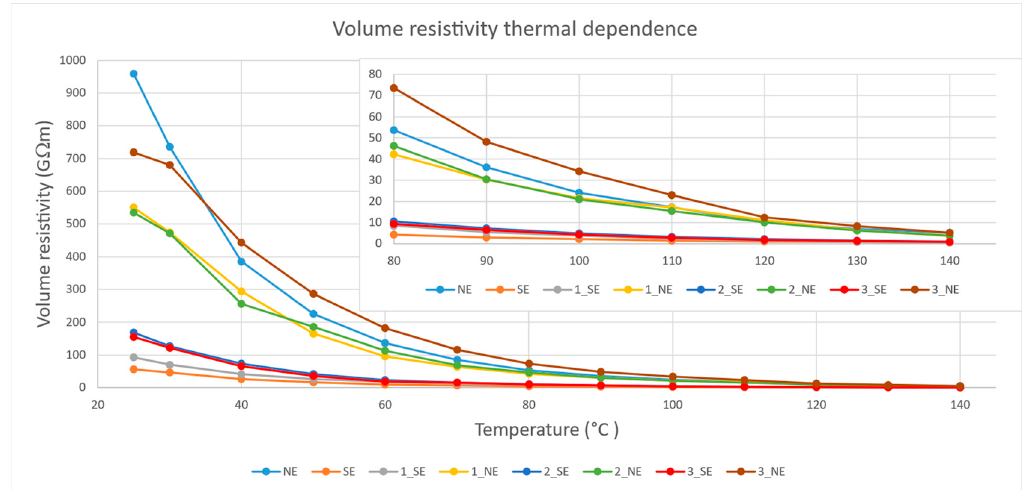
Figure 7. Volume resistivity thermal dependence (from 25 °C to 140 °C) of all examined fluids. Detailed curves at higher temperatures are shown in the upper right corner. The value of electrical stress was 0.305 kV/mm.